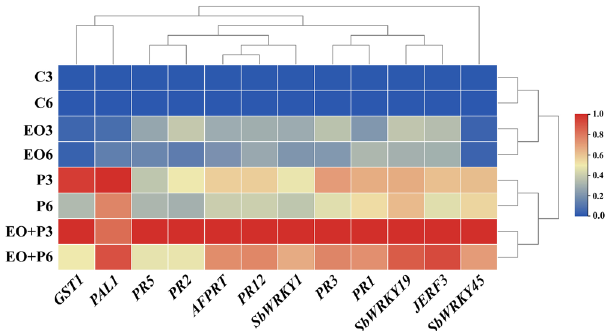
Figure 6. Hierarchical clustering heat map of transcriptional expression of three SbWRKY transcription factors and some defense-related genes in sorghum plant infected with Fusarium solani and/or treated with lavender essential oil at 1.5% after 3 and 6 days post-emergence (dpe). Where, C: untreated control, P: infected with F. solani , EO: treated with lavender essential oil at 1.5%, and P + EO: infected with F. solani and treated with lavender essential oil at 1.5%.